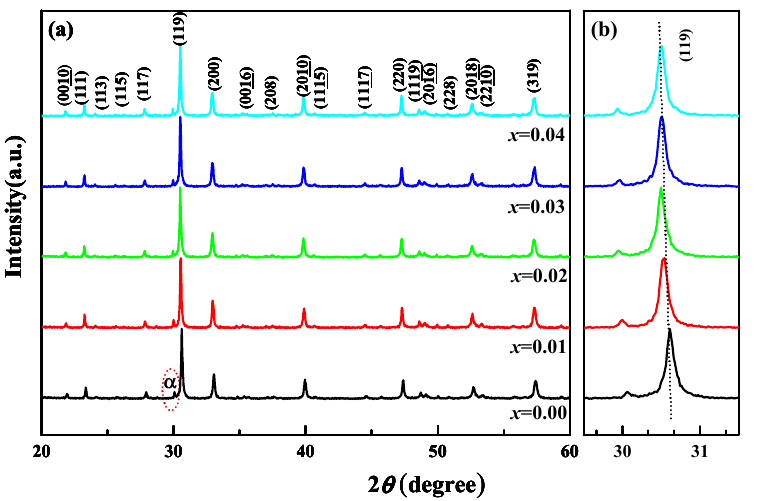
Figure 2. Room temperature X-ray diffraction patterns of the Mn/Nb co-doped NBT ceramics. ( a ) From bottom to top, Mn/Nb content 0.00, 0.01, 0.02, 0.03 and 0.04 respectively. Note: Additional peaks α : Bi 4 Ti 3 O 12 (117). ( b ) Selected (119) diffraction peak shift to the lower angle.